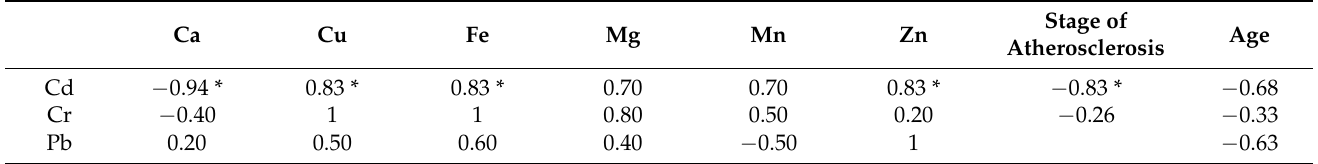
Table 3. The values of the correlation coefficients for the content of analytes in the tissue of women, considering Cd, Cr, and Pb. Statistically significant values are marked with an asterisk.